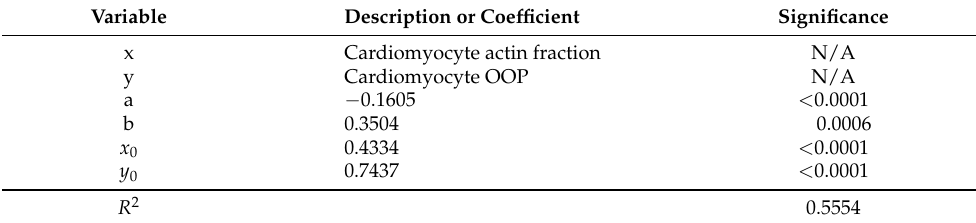
Table 3. Log-normal fit